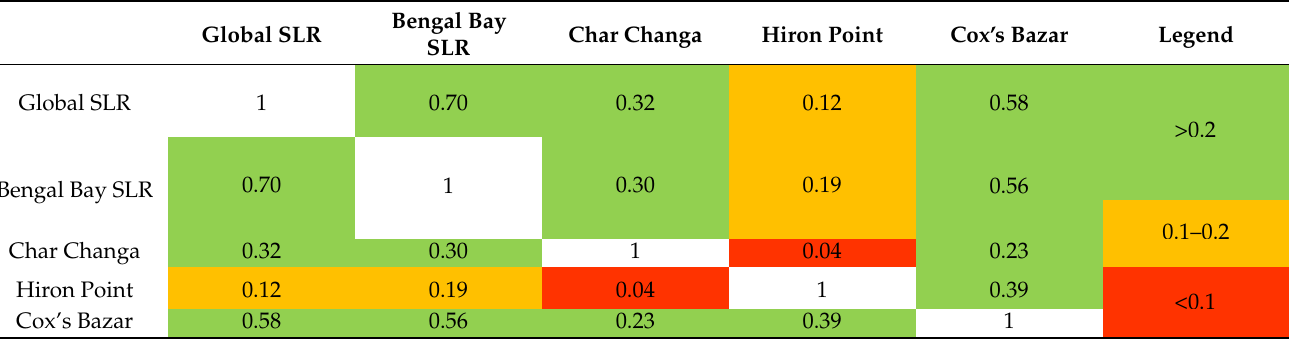
Table 6. Correlation of annual SLR data from global data, Bay of Bengal, Char Changa, Hiron Point, and Cox’s Bazar. The green color indicates correlations above R 2 = 0.2, yellow for R 2 = 0.1 and 0.2, and red for correlations less than R 2 = 0.1. Data retrieved from the Laboratory for Satellite